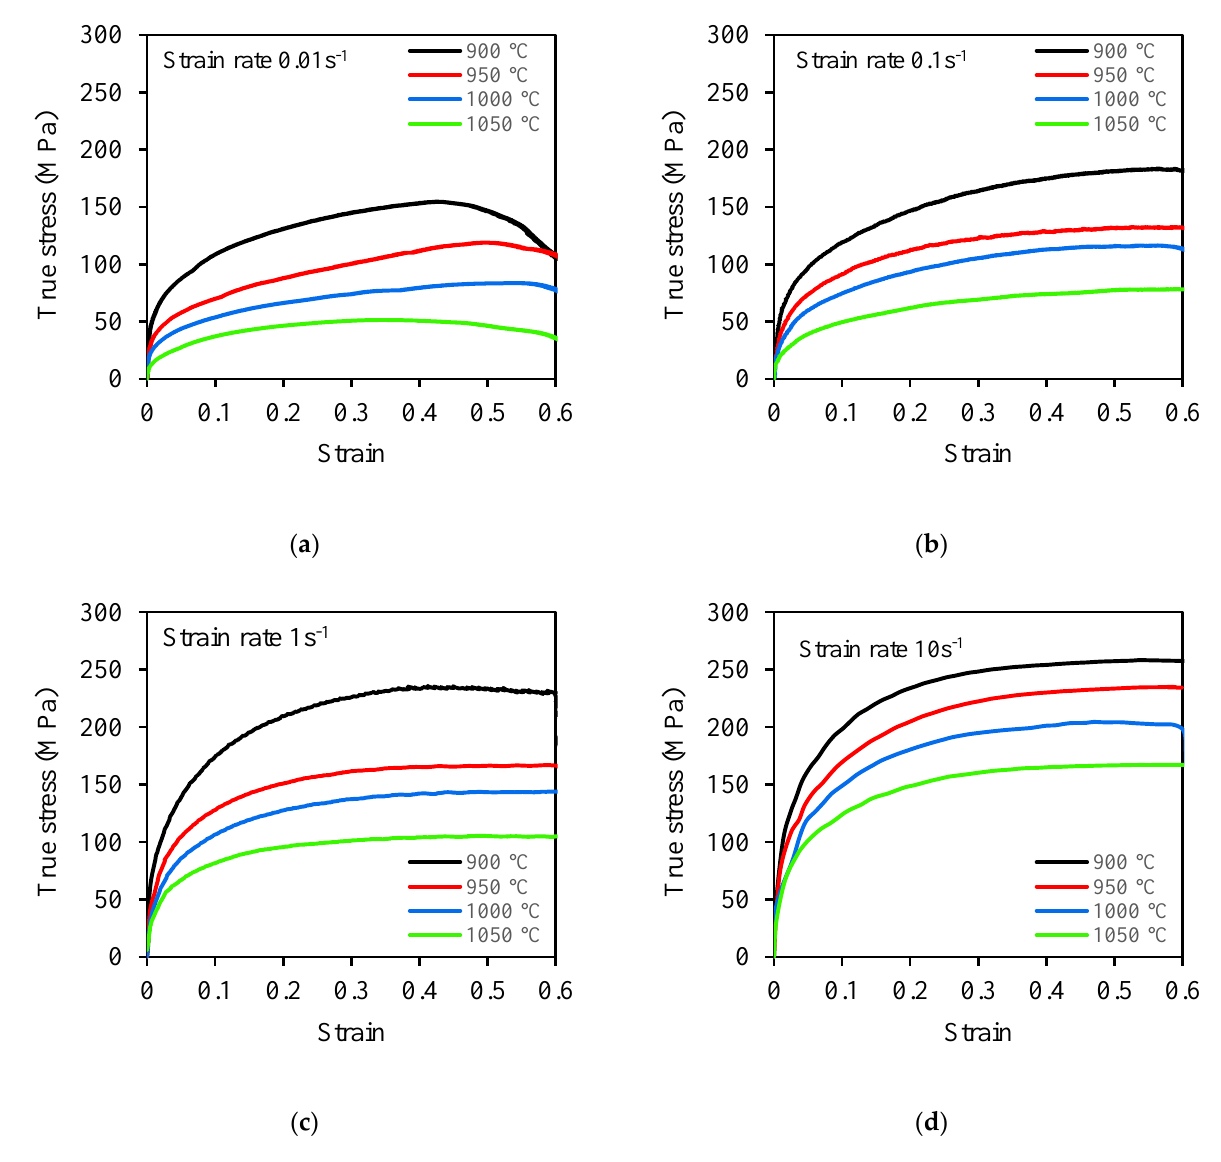
Figure 6. Flow stress–strain curves of steel B.